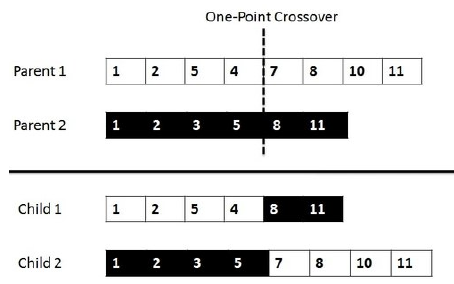
Figure 5: Crossover operator.